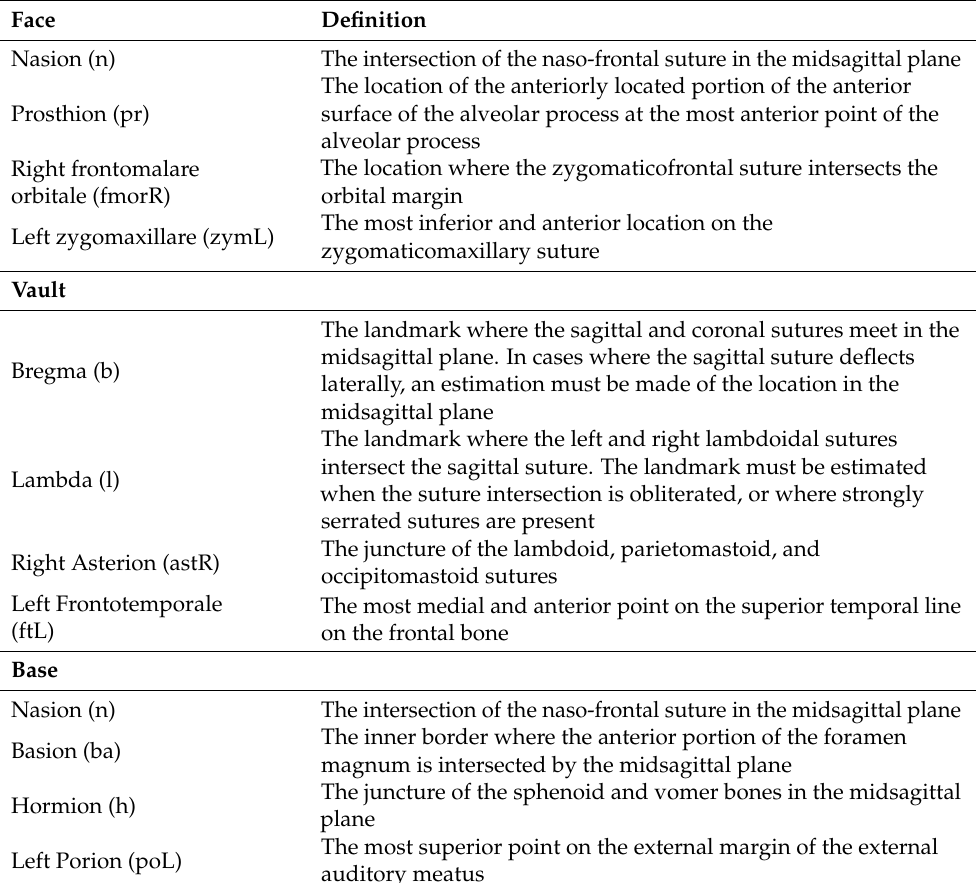
Table 2. Cranial anatomical landmarks used in this study. The four landmarks from each of the three regions produced eighteen total interlandmark distances—six for each region